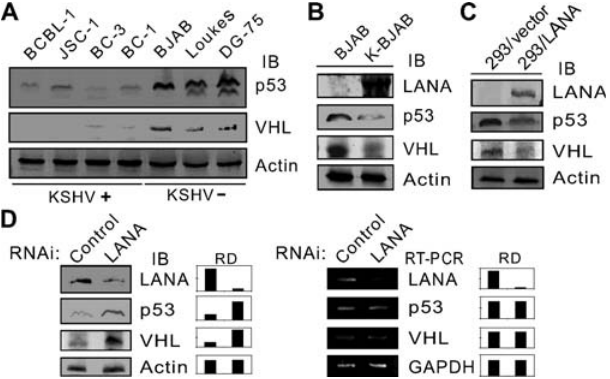
Figure 5. The Tumor Suppressors p53 and VHL Are Inhibited in the KSHV Latently Infected and LANA-Expressing Cells (A) IB analysis of KSHV-positive cell lines (BC-3, BCBL-1, JSC-1, and BC-1) and KSHV-negative cell lines (BJAB, DG-75, and Louckes) against p53 , VHL, and b -actin. Ten million of each cell line were lysed and coimmunoprecipitated using anti- VHL antibodies followed by detection with anti- VHL . Cell lysate (5%) was used in IB assays with anti- p53 and anti– b -actin. The data show that p53 and VHL in KSHV-positive cells are more strongly inhibited than in KSHV-negative cells. (B) The levels of p53 and VHL protein in B-lymphoma cells with KSHV latent infection. Ten million BJAB- or KSHV-infected BJAB (k-BJAB) cells were lysed and coimmunoprecipitated using anti- VHL antibodies followed by detection with anti- VHL . Cell lysate (5%) was used in IB assays against LANA, p53, and b -actin. The data showed that the tumor suppressor proteins p53 and VHL were inhibited during KSHV infection. (C) p53 and VHL are inhibited in the LANA stable expressing cells. Ten million 293/LANA or 293/Vector stable cell lysates were analyzed by IB against LANA, p53, and VHL as described previously. The data showed that LANA decreases tumor suppressor p53 and VHL levels. (D) p53 and VHL turnover in the LANA knockdown BCBL-1 cells. Cell lysates from stable BCBL-1 cells with LANA or control firefly luciferase knockdown (RNAi) were subjected to IB assays (left panel) against LANA, p53, VHL, and b -actin, or total RNA underwent RT-PCR analysis (right panel). RD, relative